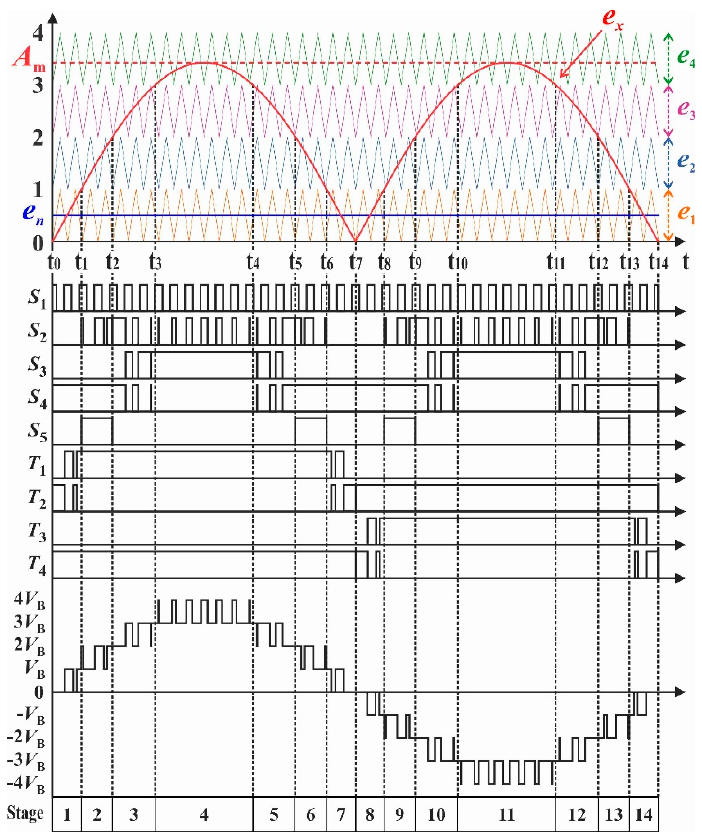
Figure 2. Modulation method for the proposed single-phase NLBI.